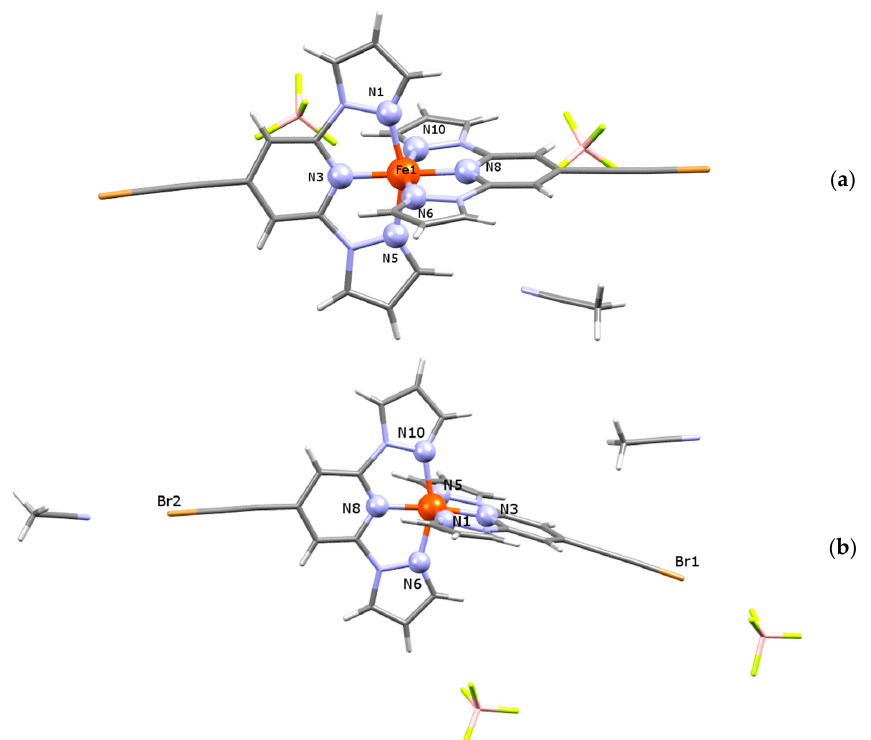
Figure 2. Asymmetric unit of solvated analogues ( a ) ( 1 ) and ( b ) ( 2 ).